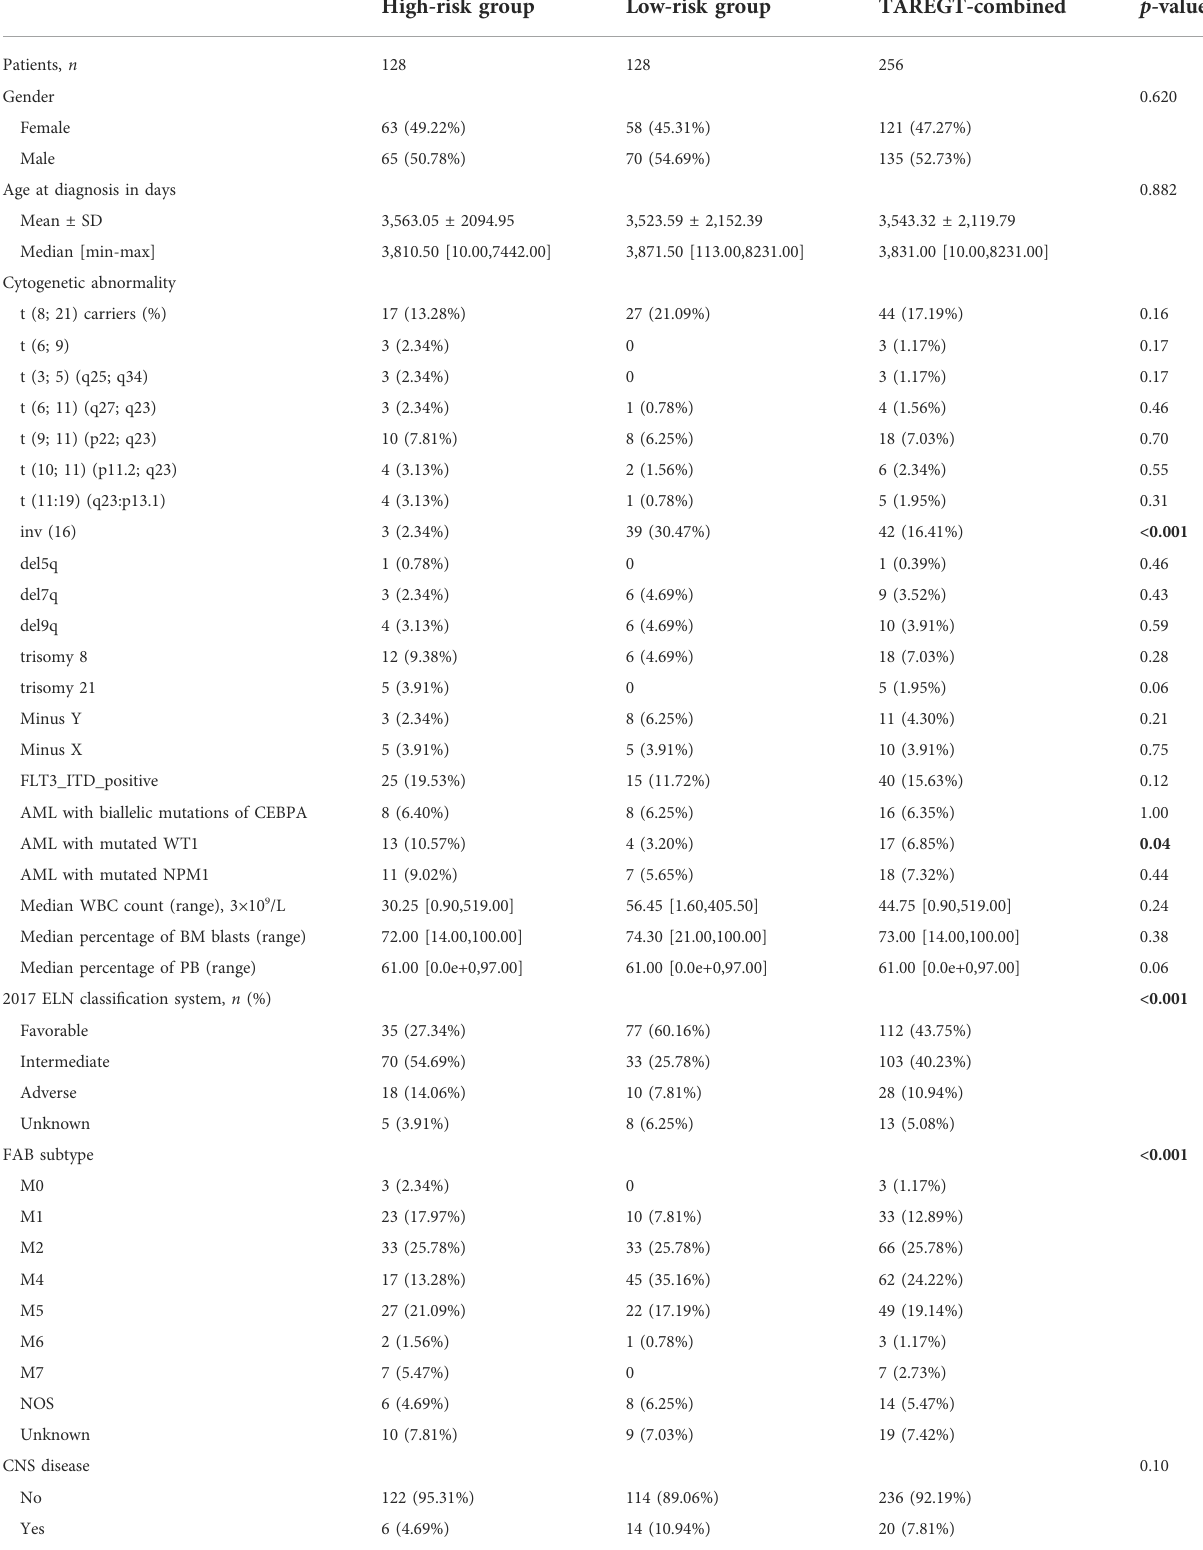
TABLE 2 Clinicopathological Characteristics for high and low FGL risk score